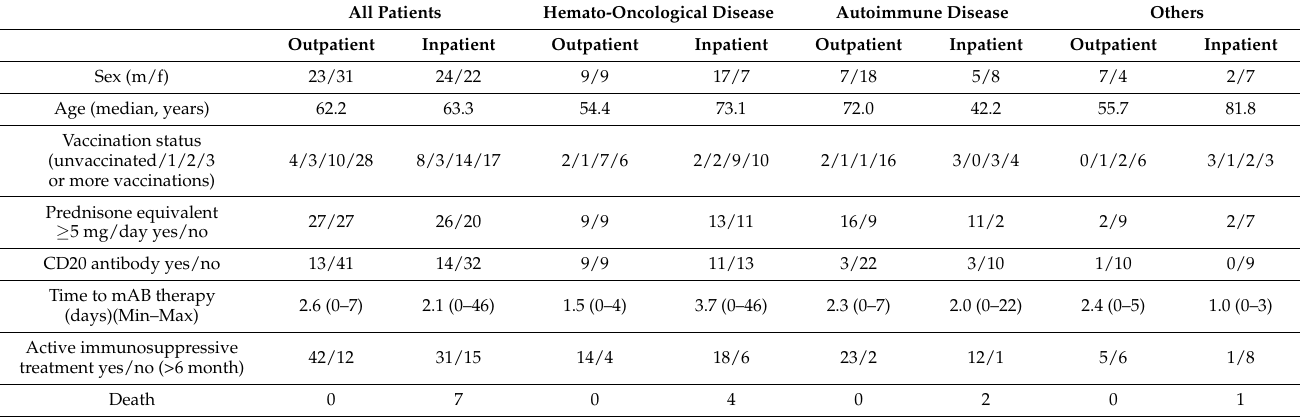
Table 1. Patient